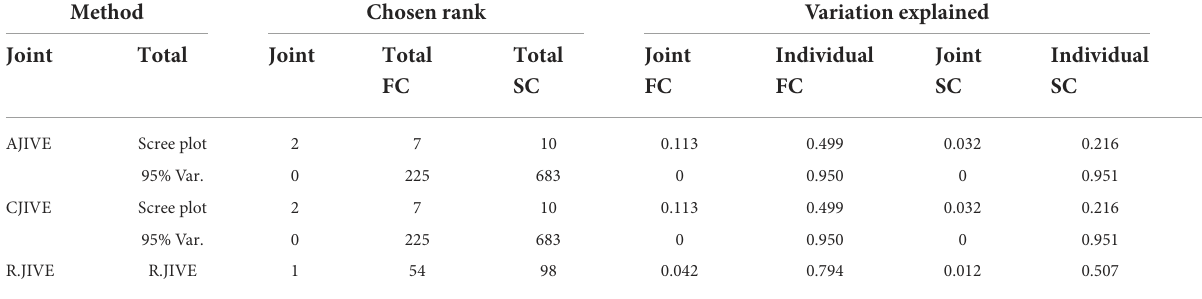
TABLE 2 Estimated joint and total signal ranks and joint and individual variation explained in the functional connectivity (Pearson correlations) and the dMRI (streamline counts) HCP data. Method Chosen rank Variation explained Joint Total